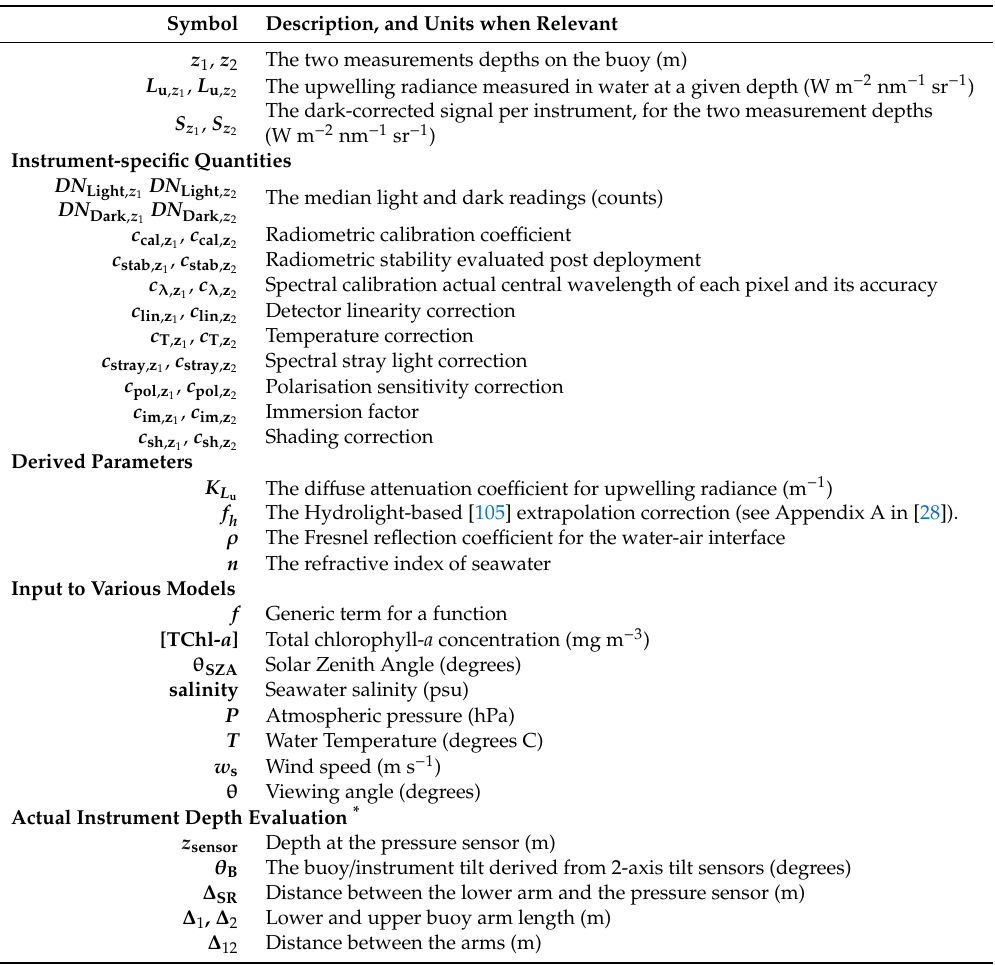
Table A1. List of all symbols used in Figure